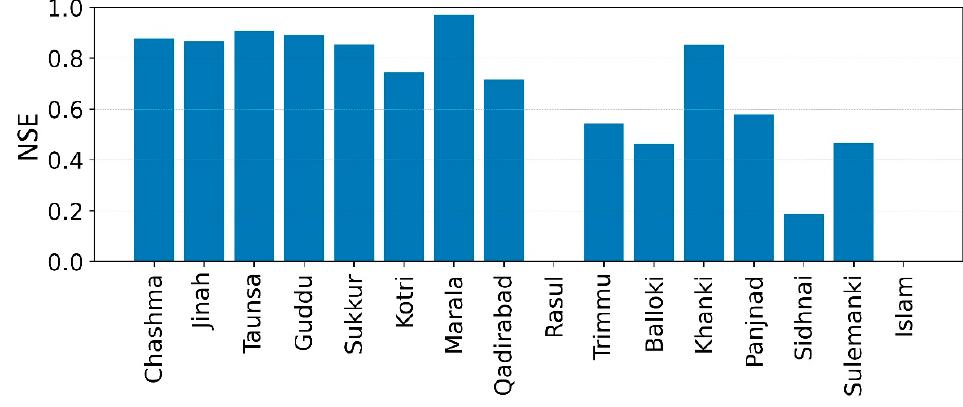
Figure 8. Daily model Nash–Sutcliffe coefficient of efficiency (NSE) (2002–2012) upstream of bar- rages.